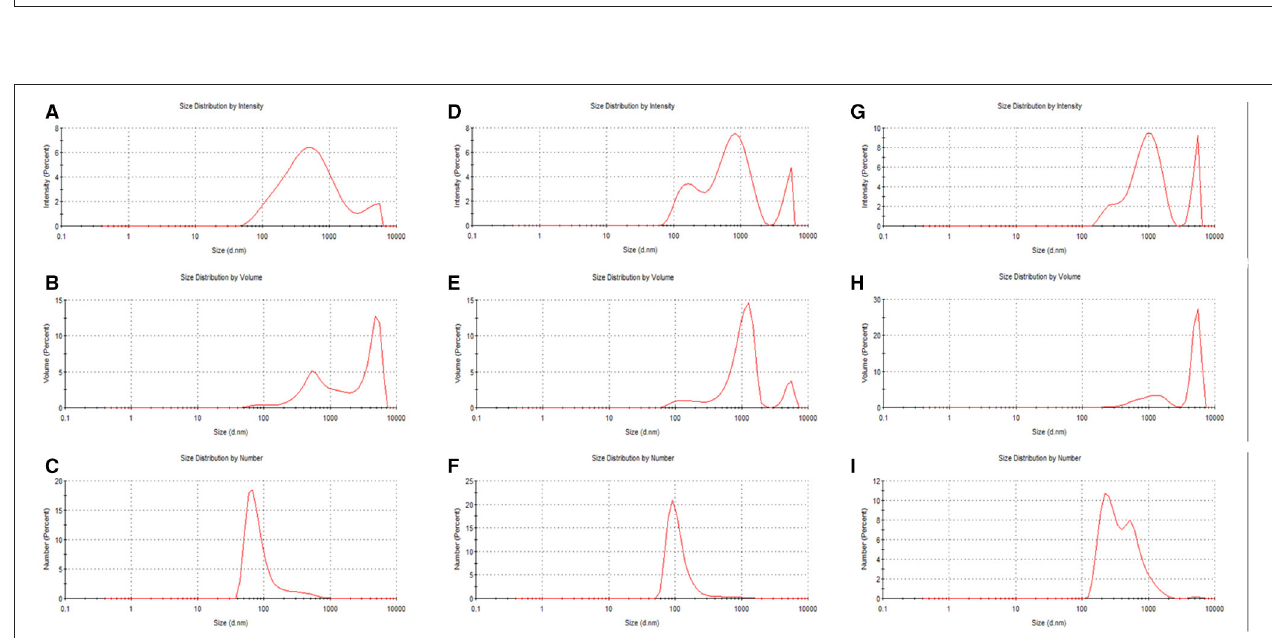
FIGURE 3 | Intensity, volume and number particle size distributions of PPHA dissolved in 0.01M NaOH (A–C) , PPFA dissolved in 0.01M NaOH (D–F) , and PPFA dissolved in water (G–I) . The concentration of all solutions was 0.01g dm − 3 .